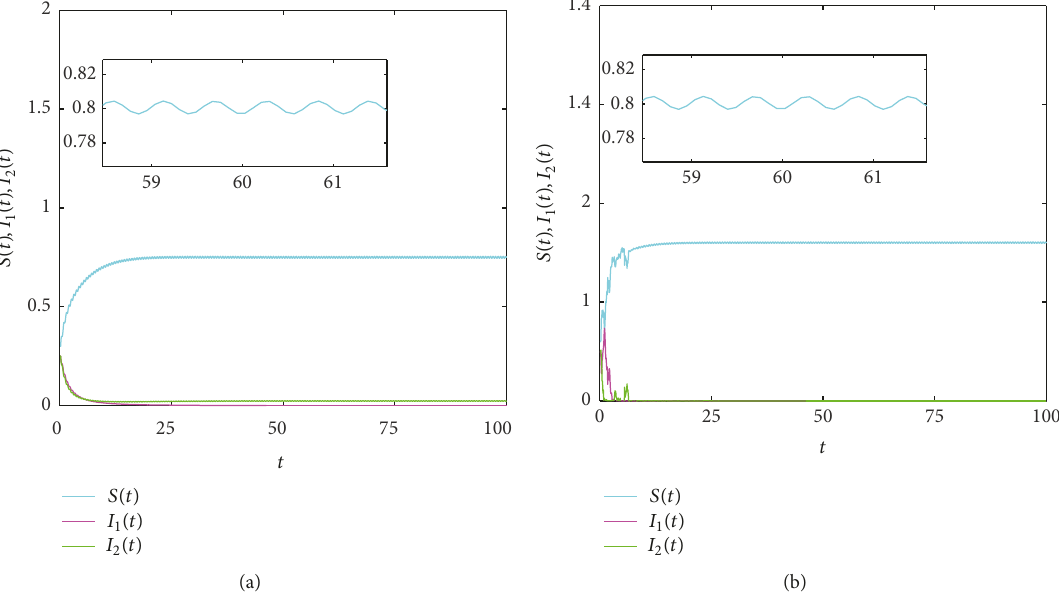
Figure 2: The solution (𝑆(𝑡),𝐼 1 (𝑡),𝐼 2 (𝑡)) = (0.3, 0.25, 0.25) to the nonautonomous stochastic model (3). (𝑡) = 0.3 + 0.2 sin 𝛽 2